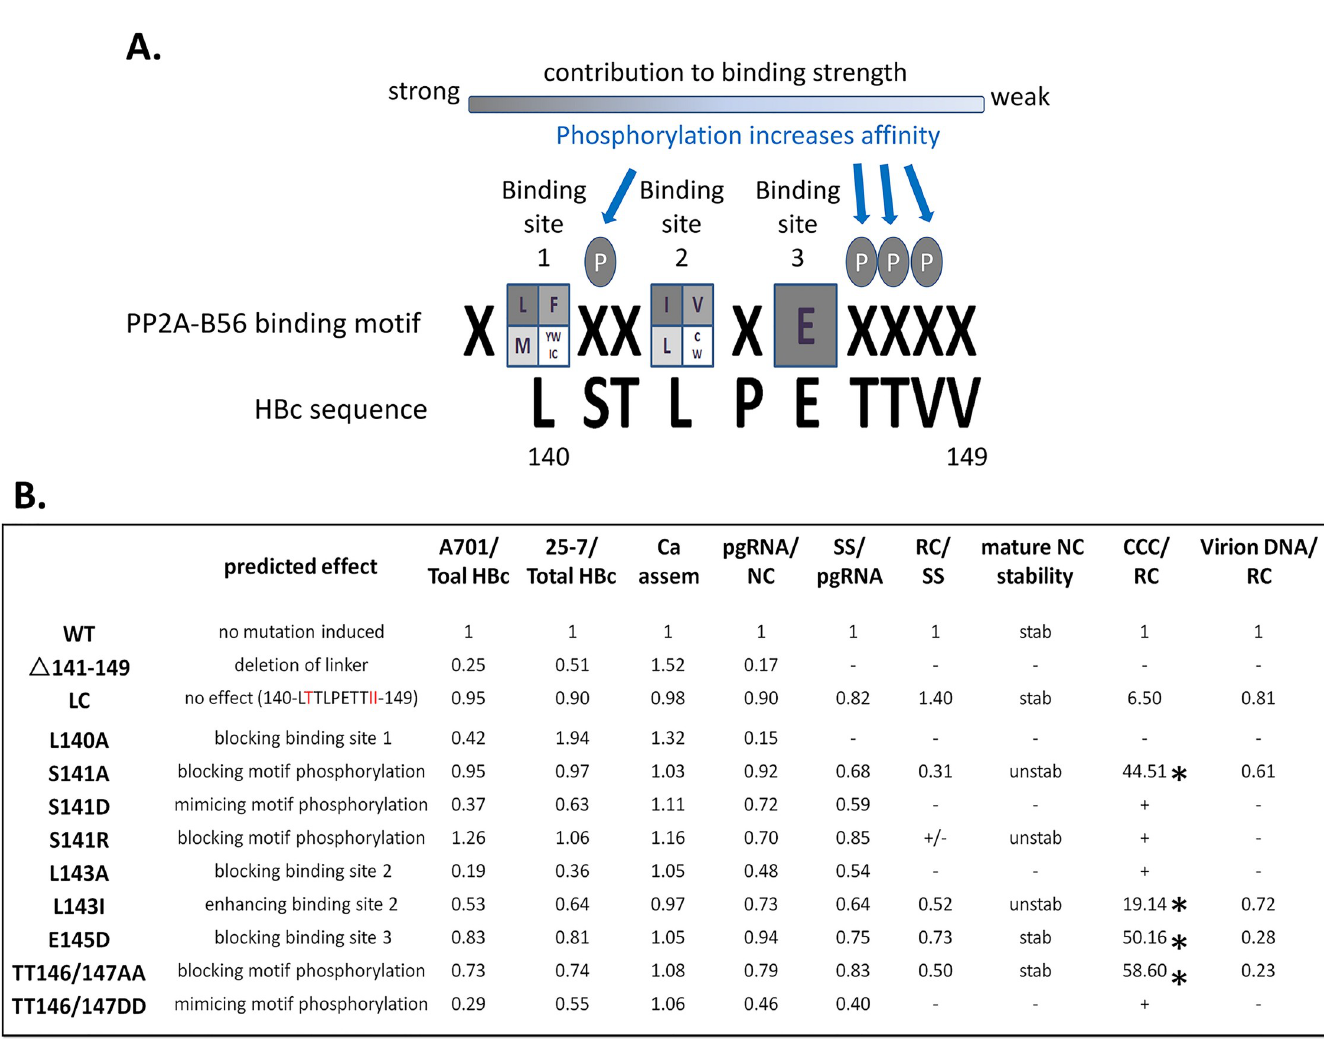
Fig 1. Summary of the effects of HBc linker mutants on different steps of viral replication. A. Alignment of HBc linker sequence (‘141–149), including the last residue of NTD (140), with the consensus PP2A-B56 binding motif. B. Mutations in the B56 binding motif and predicted effects on B56 binding, and observed effects of the mutations on HBc CTD dephosphorylation at two distinct mAb epitopes—A701 (T160/S162) and 25–7 (S178)—both normalized to total HBc levels, capsid assembly (Ca assem), pgRNA packaging (pgRNA/NC), SS DNA synthesis (SS/pgRNA), RC DNA synthesis (RC/SS), mature NC stability, CCC DNA synthesis (CCC/ RC), and DNA virion secretion (virion DNA/RC), with the level for each parameter from the WT HBc set to 1.0. N/A, not applicable due to the lack of detection of RC DNA; -/+, very weak signal detected; -, below the limit of detection; unstab, unstable NC; stab, stable NC as WT; � , CCC DNA decreased during infection. +, CCC DNA generated but no detectable core RC DNA, so CCC DNA/RC DNA normalization was impossible. The red font in the mutant LC indicates the amino acid change from the WT sequence (S141T and